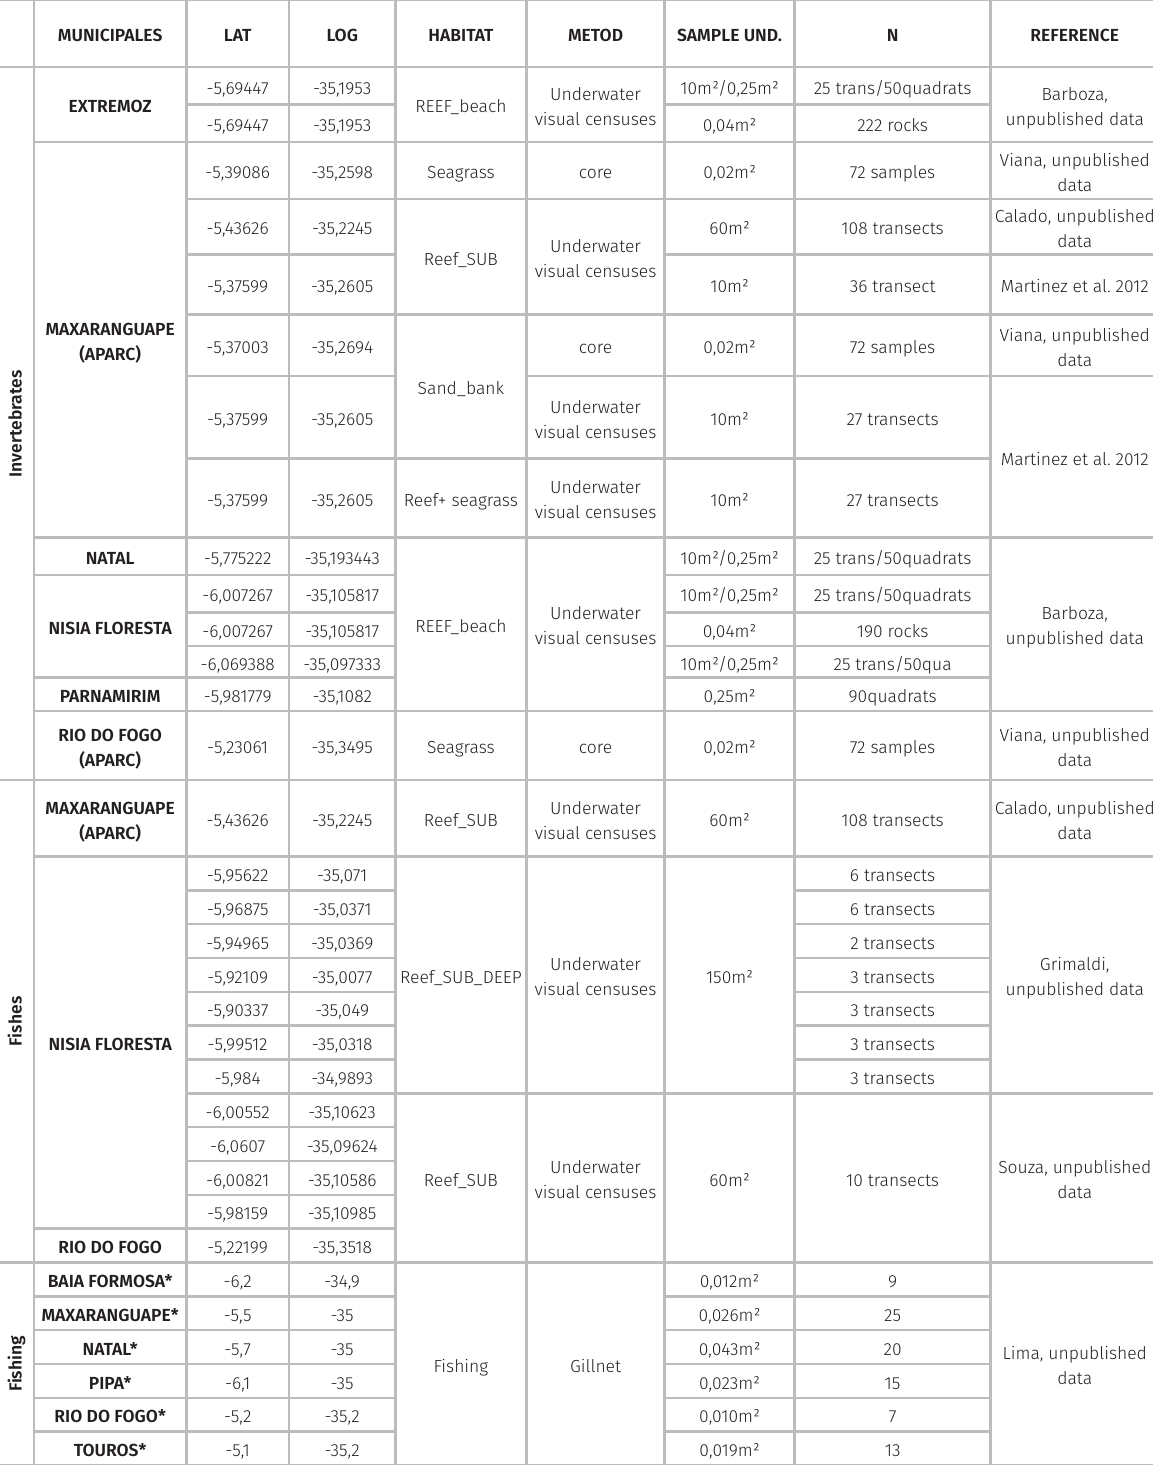
Table I. Information on the sampling methodology applied in each study for data collection of fishes and invertebrates on the eastern coast of RN. *Coordinates of fishing areas are approximate values. MUNICIPALES SAMPLE